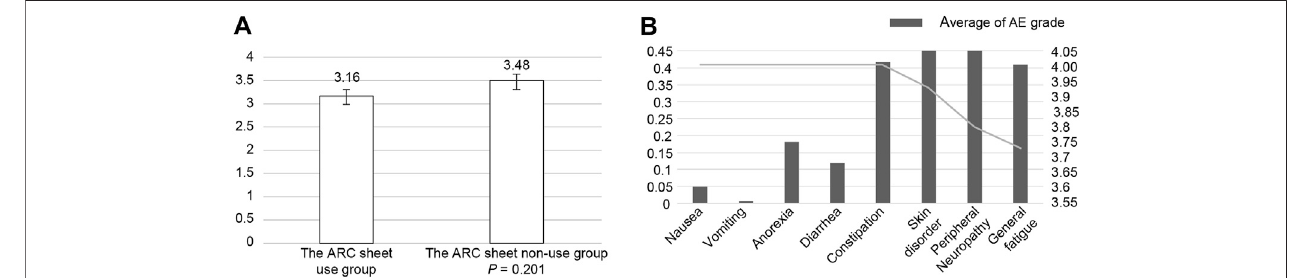
FIGURE2|(A) :Patients ’ satisfaction withtheabilityoftheARCsheet torelievetheiranxietyaboutbeing abletocommunicateadverse eventstotheirdoctors. The ARCsheetgrouptendedtohavelessanxietyaboutwhetheradverseeventswouldbecommunicated,althoughthedifferencewasnotsigni fi cant. (B) :Inthegroupusing the ARC sheet, the mean CTCAE grade of adverse events obtained from the ARC sheet was compared with the satisfaction with the ease of communicating adverse events obtained from the patient questionnaire. Increased adverse events affected satisfaction with pre-examination interviews.